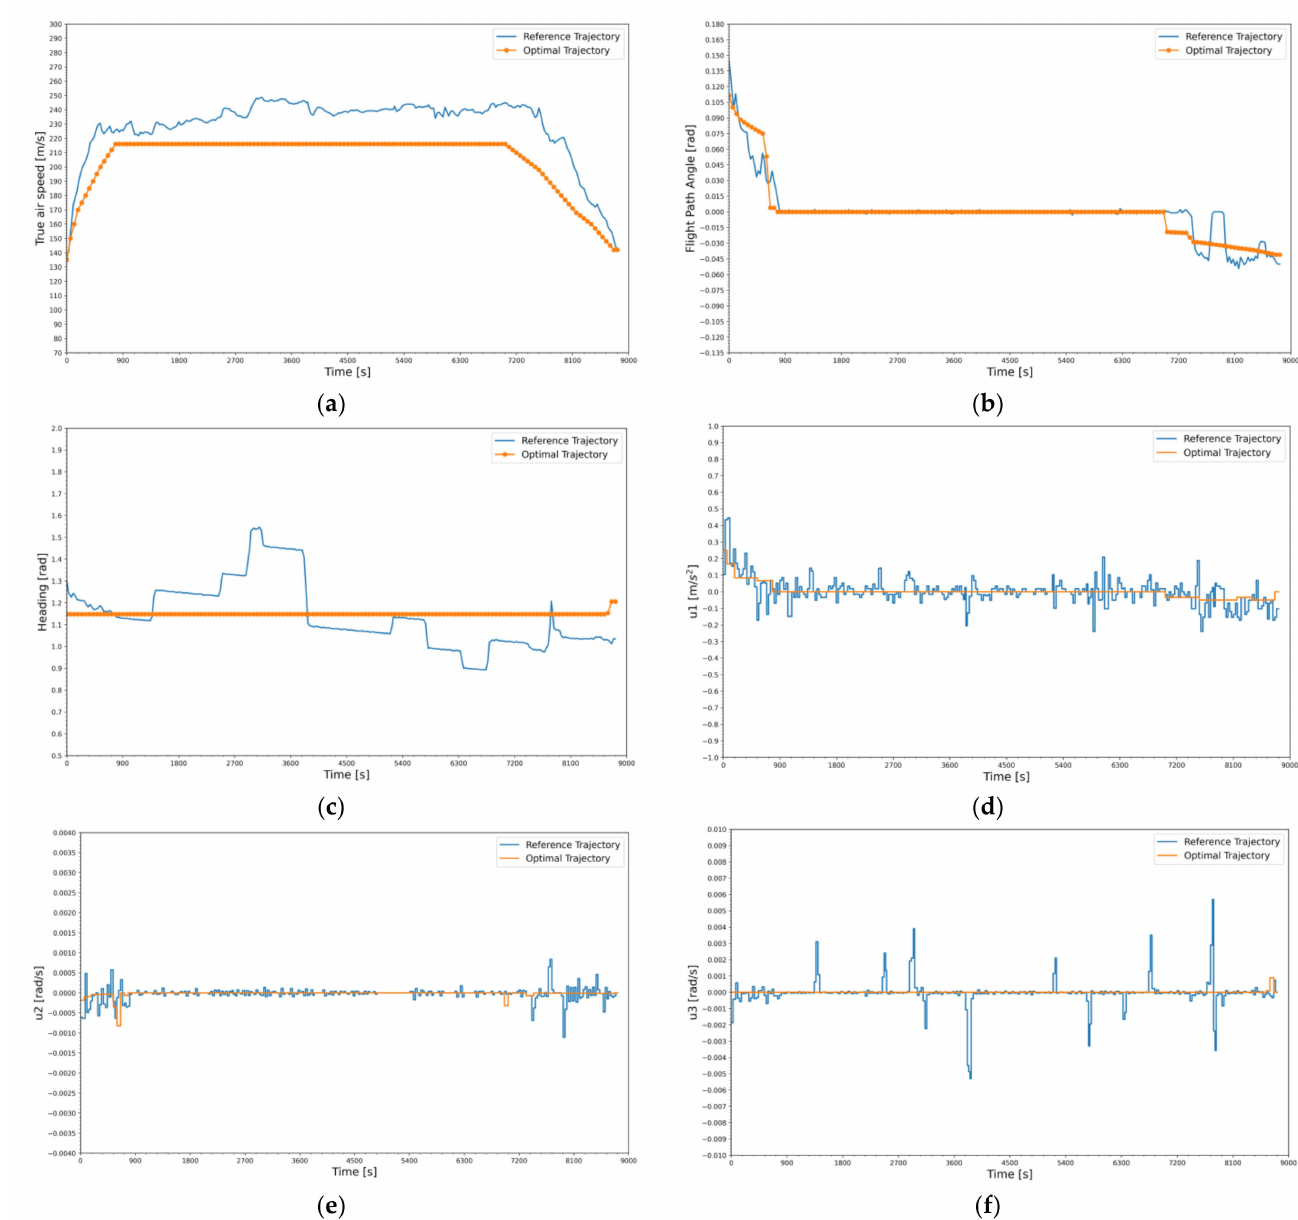
Figure 7. Comparison of reference and emissions-optimal trajectories: ( a ) true air speed vs. time; ( b ) flight path angle vs. time; ( c ) heading vs. time; ( d ) control u 1 vs. time; ( e ) control u 2 vs. time; and ( f ) control u 3 vs.